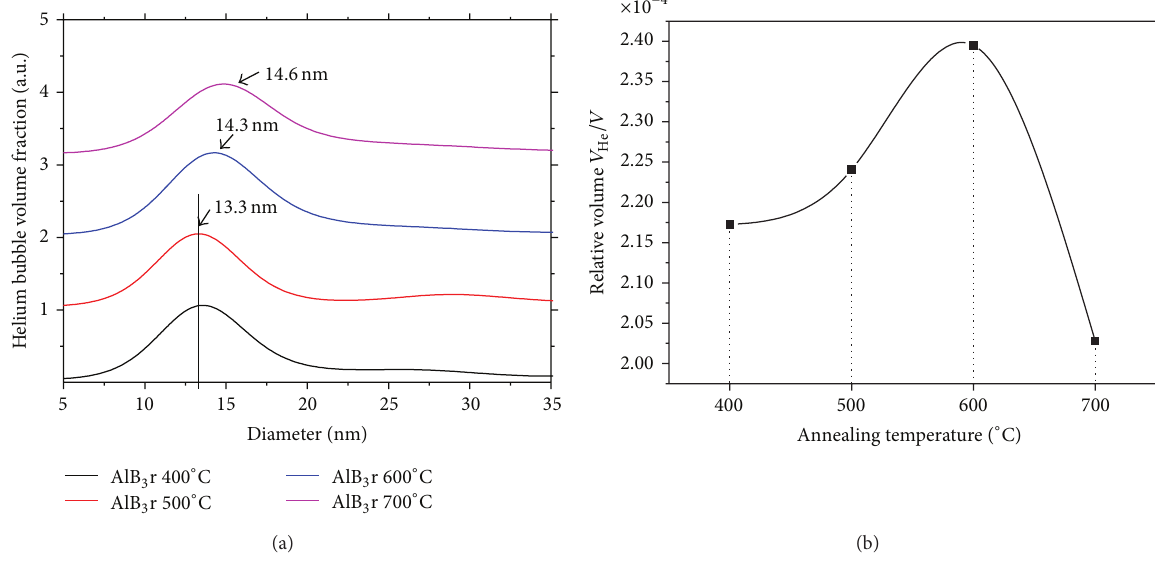
Figure 4: SAXS analysis of the volume-weighted size distribution of samples tempered at different